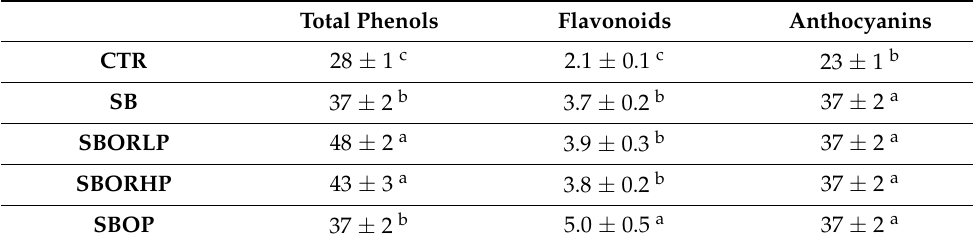
Table 1. Total phenols (mg · GAE · g − 1 DW), flavonoids (mg · rutin · g − 1 DW), and anthocyanins (mg · cyanidin-3-glucosideg − 1 DW) found in red onion bulbs differently fertilized: control (CTR), sulphur bentonite (SB), sulphur bentonite-low percentage orange residue (SBOR LP), sulphur bentonite-high percentage orange residue (SBOR HP), and sulphur bentonite-olive pomace (SBOP). Data are the mean of three replicates ± the standard error.